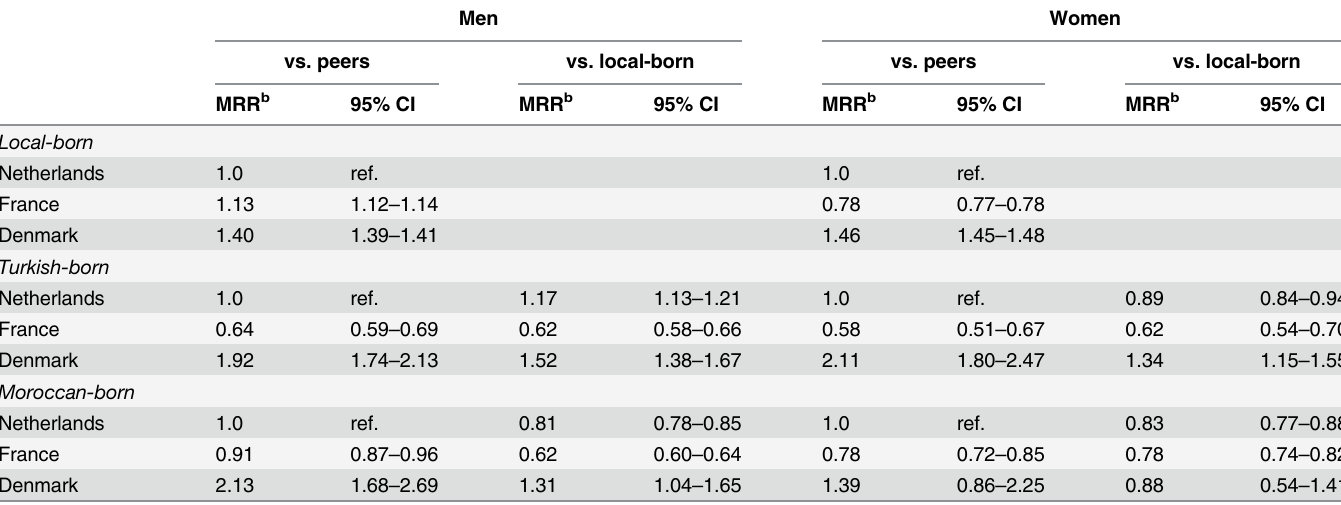
Table 2. All-cause mortality rate ratios (MRRs) in Turkish- and Moroccan-born immigrants in three European countries, compared with the local- born population a and with peers in the Netherlands, stratified by sex.